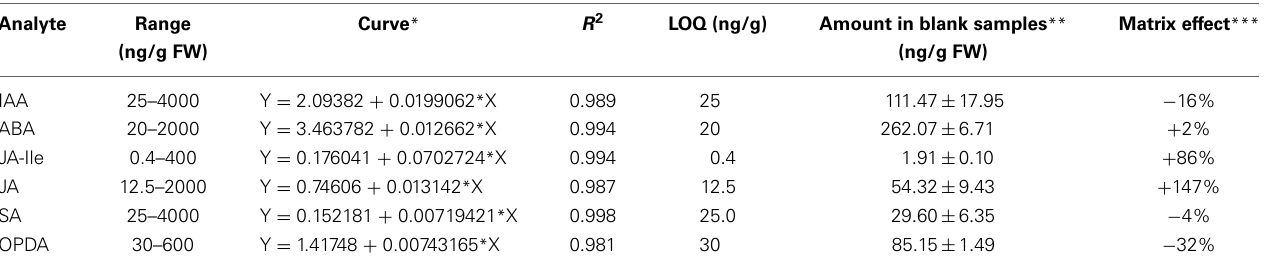
Table 5 | Parameters of calibration curve for each phytohormone: curve range, regression, weighting, correlation coefficient, limit of quantification (LOQ) and amount of each phytohormone present in blank Citrus sinensis samples.